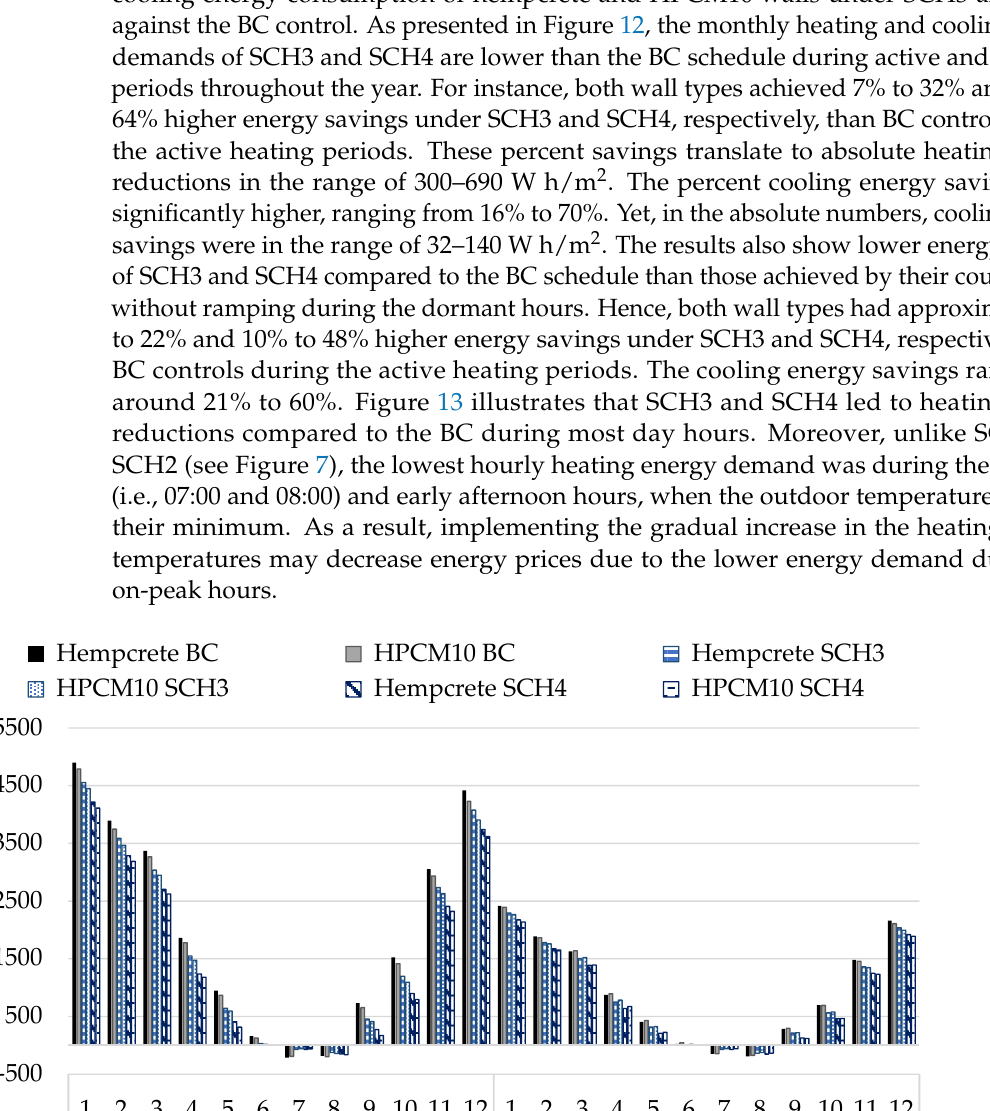
Figure 13. Average hourly heating and cooling energy consumption under BC, SCH3, and SCH4. Figure 14 provides further insight into the performance of the HPCM10 wall under control strategies with (SCH3 and 4) and without (SCH1 and 2) ramping of the heating setpoint temperatures during the winter months of November to March. Comparing the average hourly heating energy consumption of HPCM10 assembly shows very different performances between the four control strategies. For example, the SCH1 and SCH2 had 13% to 51%, respectively, higher heating energy demand during active hours than SCH3 and SCH4. Morning hours between 08:00 and 09:00 had a particularly pronounced energy demand difference ranging between 25% and 51%. In contrast, the SCH1 and SCH2 ex- hibited between 46% and 81% lower heating energy demand during the dormant hours than the SCH3 and SCH4. These findings provide additional evidence about the ability of HPCM10 walls to behave as thermal batteries. Thus, sudden setpoint temperature change under SCH1 and SCH2 caused the wall assemblies to charge during the morning and early